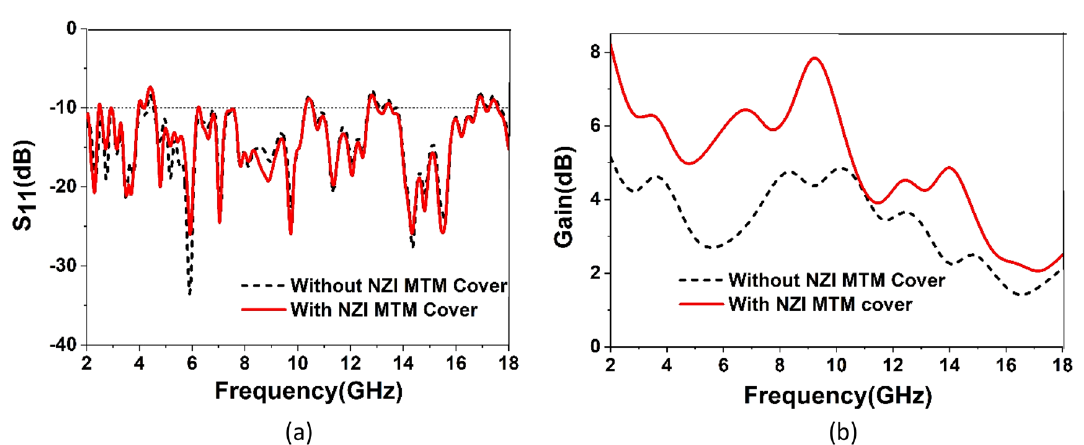
Figure 31. Antenna performance without and with MTM cover ( a ) Reflection coefficient ( b )